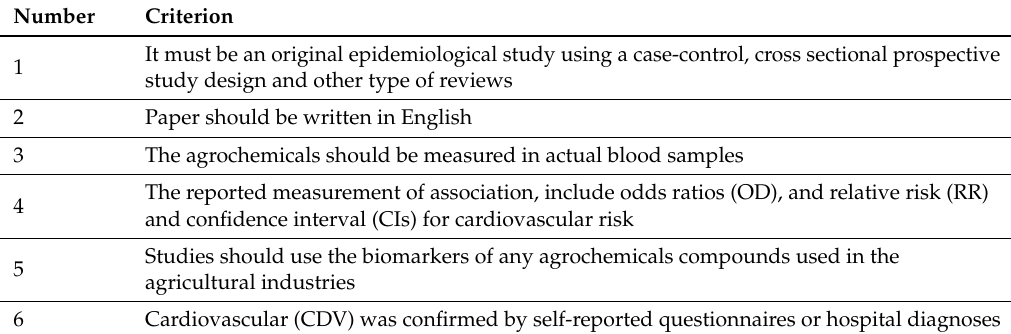
Table 1. Inclusion criteria for research articles to be used in compiling this non meta-analysis